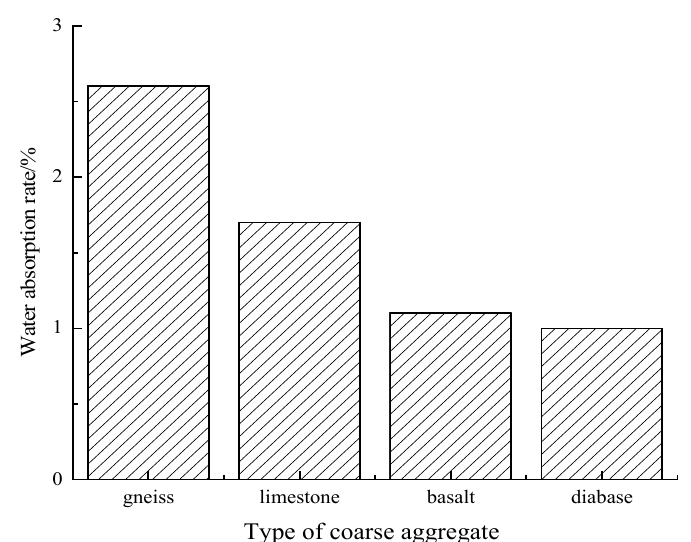
Figure 2. Water absorption of a coarse aggregate.